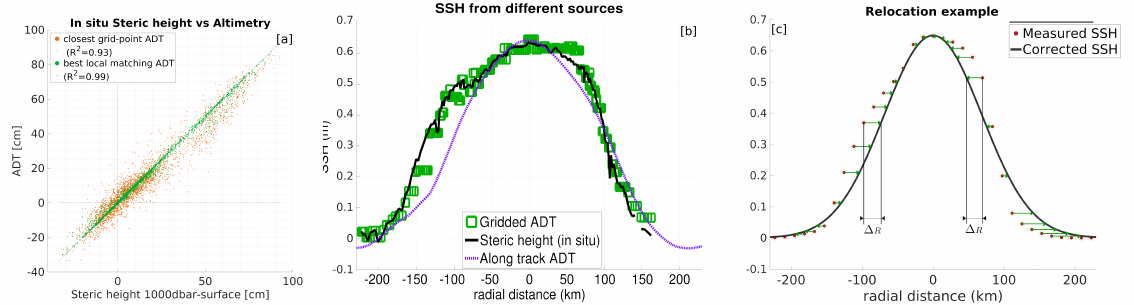
Figure 3. ( a ) Absolute dynamic topography (ADT) against Steric height referenced at 1000 dbar. The orange dots show the ADT value at the closest grid point from the in situ vertical profile location. The green dots show the closest matching ADT value within a radius of 50 km from the in situ vertical profile. The coefficients of determinations between steric height and ADT are shown in the text box for each method. ( b ) Estimate of the cross-eddy sea surface height (SSH) from 3 different sources. The black line is the glider-measured in situ steric height. The green squares are Absolute Dynamic Topography (ADT) interpolated from the 0.25 ◦ grid to the glider’s location. The dashed purple line is an along-track ADT profile measured at the median time of the glider transect (August 19). ( c ) Schematic representation of the relocation method: The along-track SSH (ADT) profile is used as a synoptic reference profile. Each glider dive is moved by a different distance ∆ R , so that the in situ steric height corresponds to the closest along-track altimetry